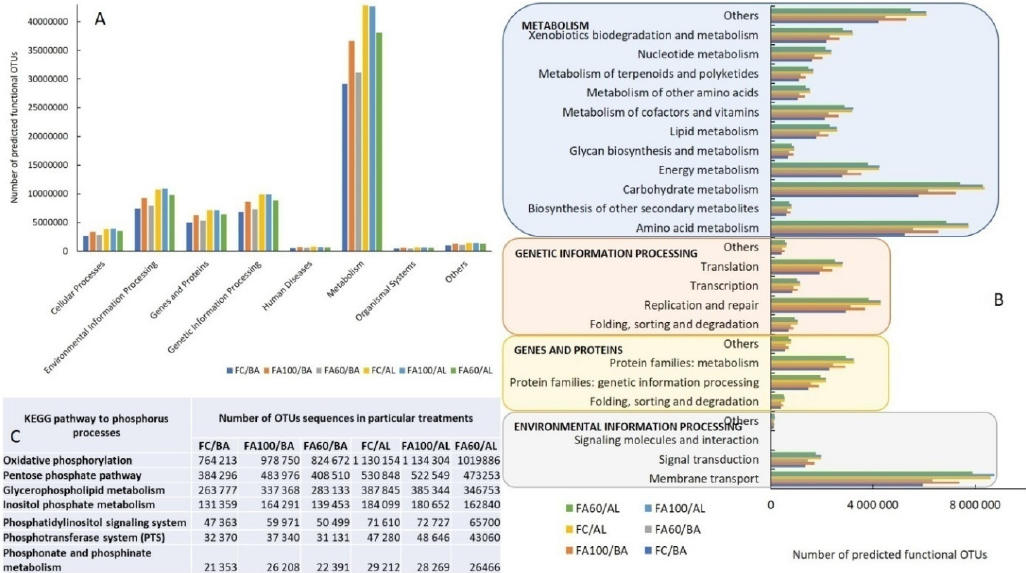
Figure 12. Variation in bacterial function profiles after biofertilizers application in Brunic Arenosol and Abruptic Luvisol soils analysed by PICRUSt. ( A )—Biochemical metabolic pathways, ( B )—